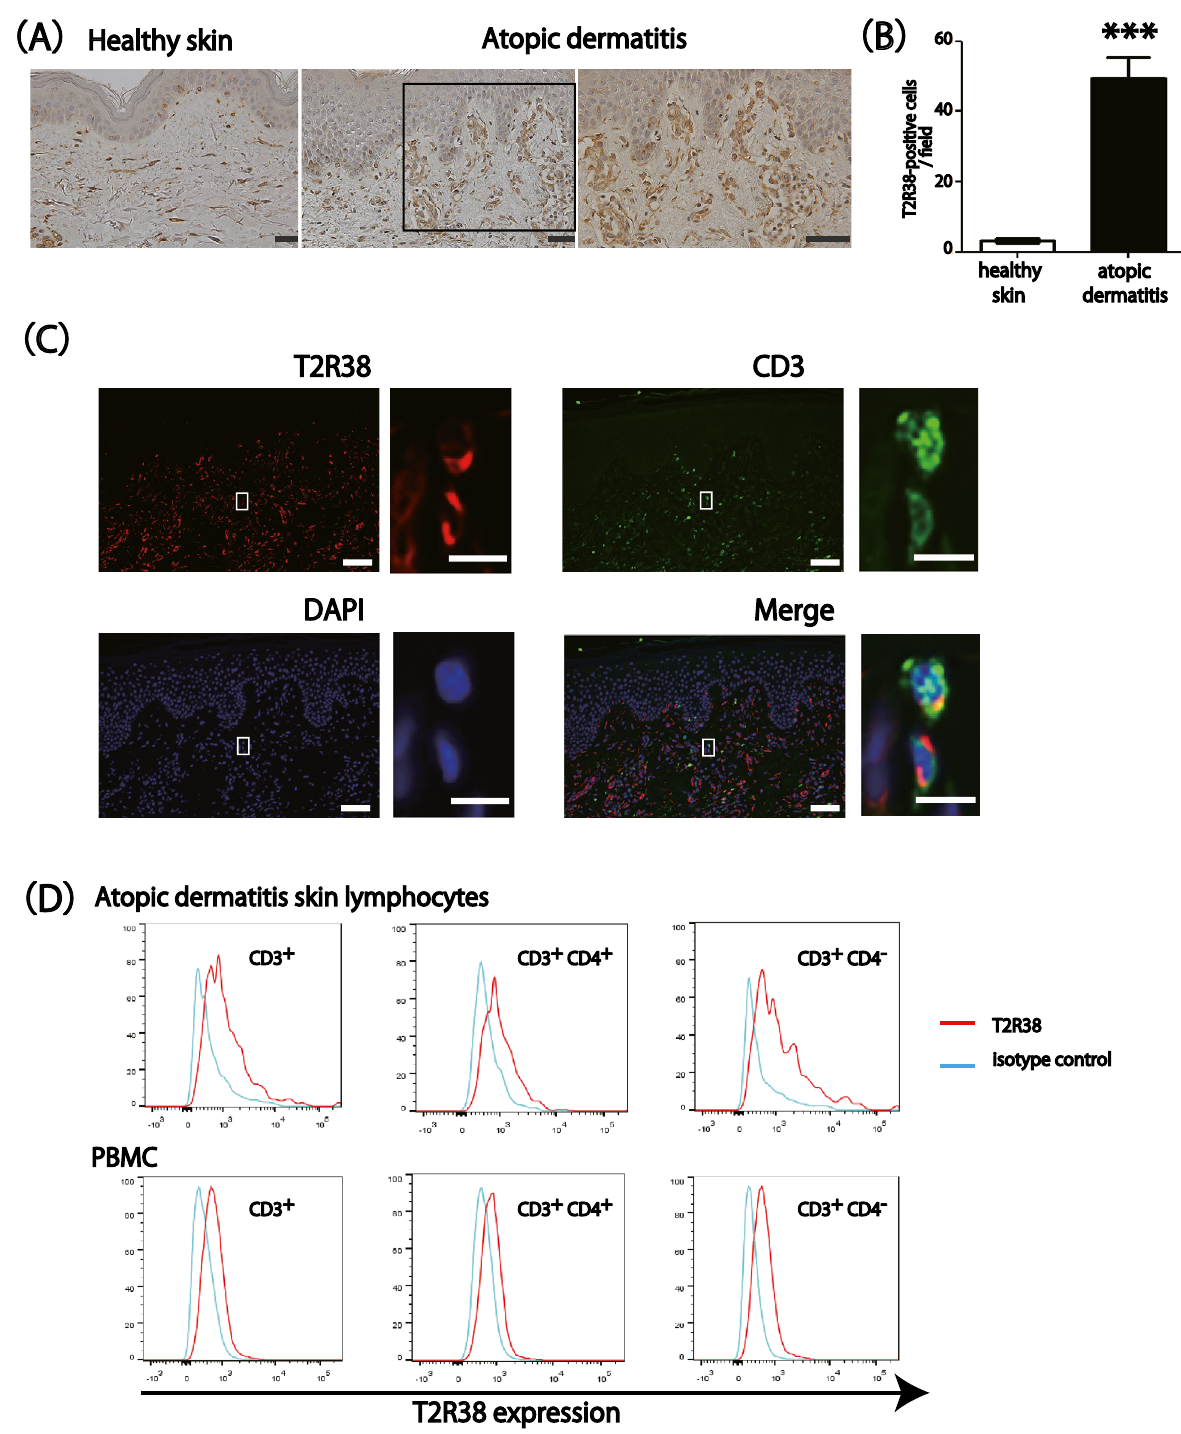
Figure 2. T2R38 expression on skin-infiltrating lymphocytes in atopic dermatitis (AD). ( A ) Representative images of immunohistochemical staining for T2R38 in lesional skin tissue from healthy control and AD. Bars = 100 μm. ( B ) Quantification of T2R38 positive cells/field in skin tissue. In the cell count of positive cells in immunohistochemical staining, stained cells were counted in 10 random grids under high-power fields. Skin tissue samples were obtained from four patients with AD and four healthy individuals. ( C ) Representative image of fluorescent double staining for CD3 and T2R38 in lesional skin tissue of AD. Bars = 100 μm. Enlarged images from rectangles in each panels are shown on the right. Bars = 20 μm. T2R38 = red, CD3 = green, DAPI = blue. ( D ) One representative of two independent experiments is shown. Flow cytometric analysis of T2R38 expression levels in skin-infiltrating lymphocytes in lesional skin AD and PBMC from AD patients. *** P < 0.001 by Student’s t